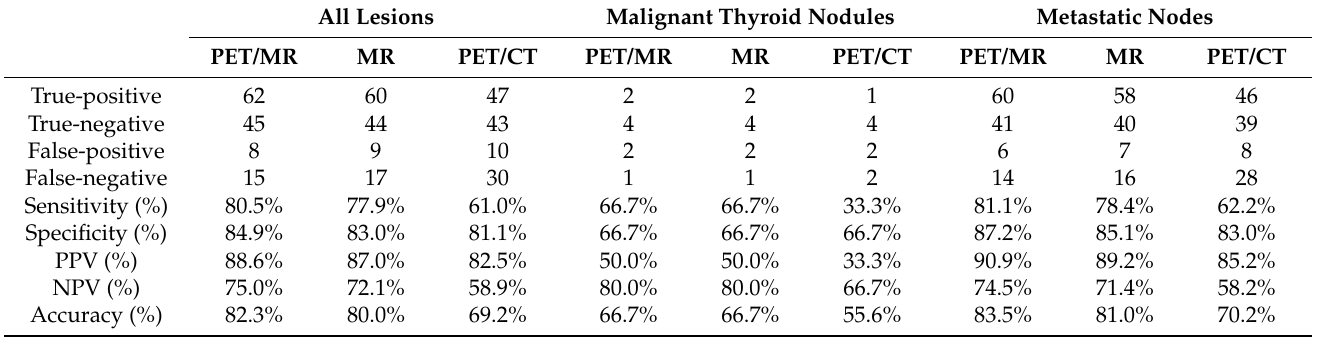
Table 3. Diagnostic performance of two modalities.